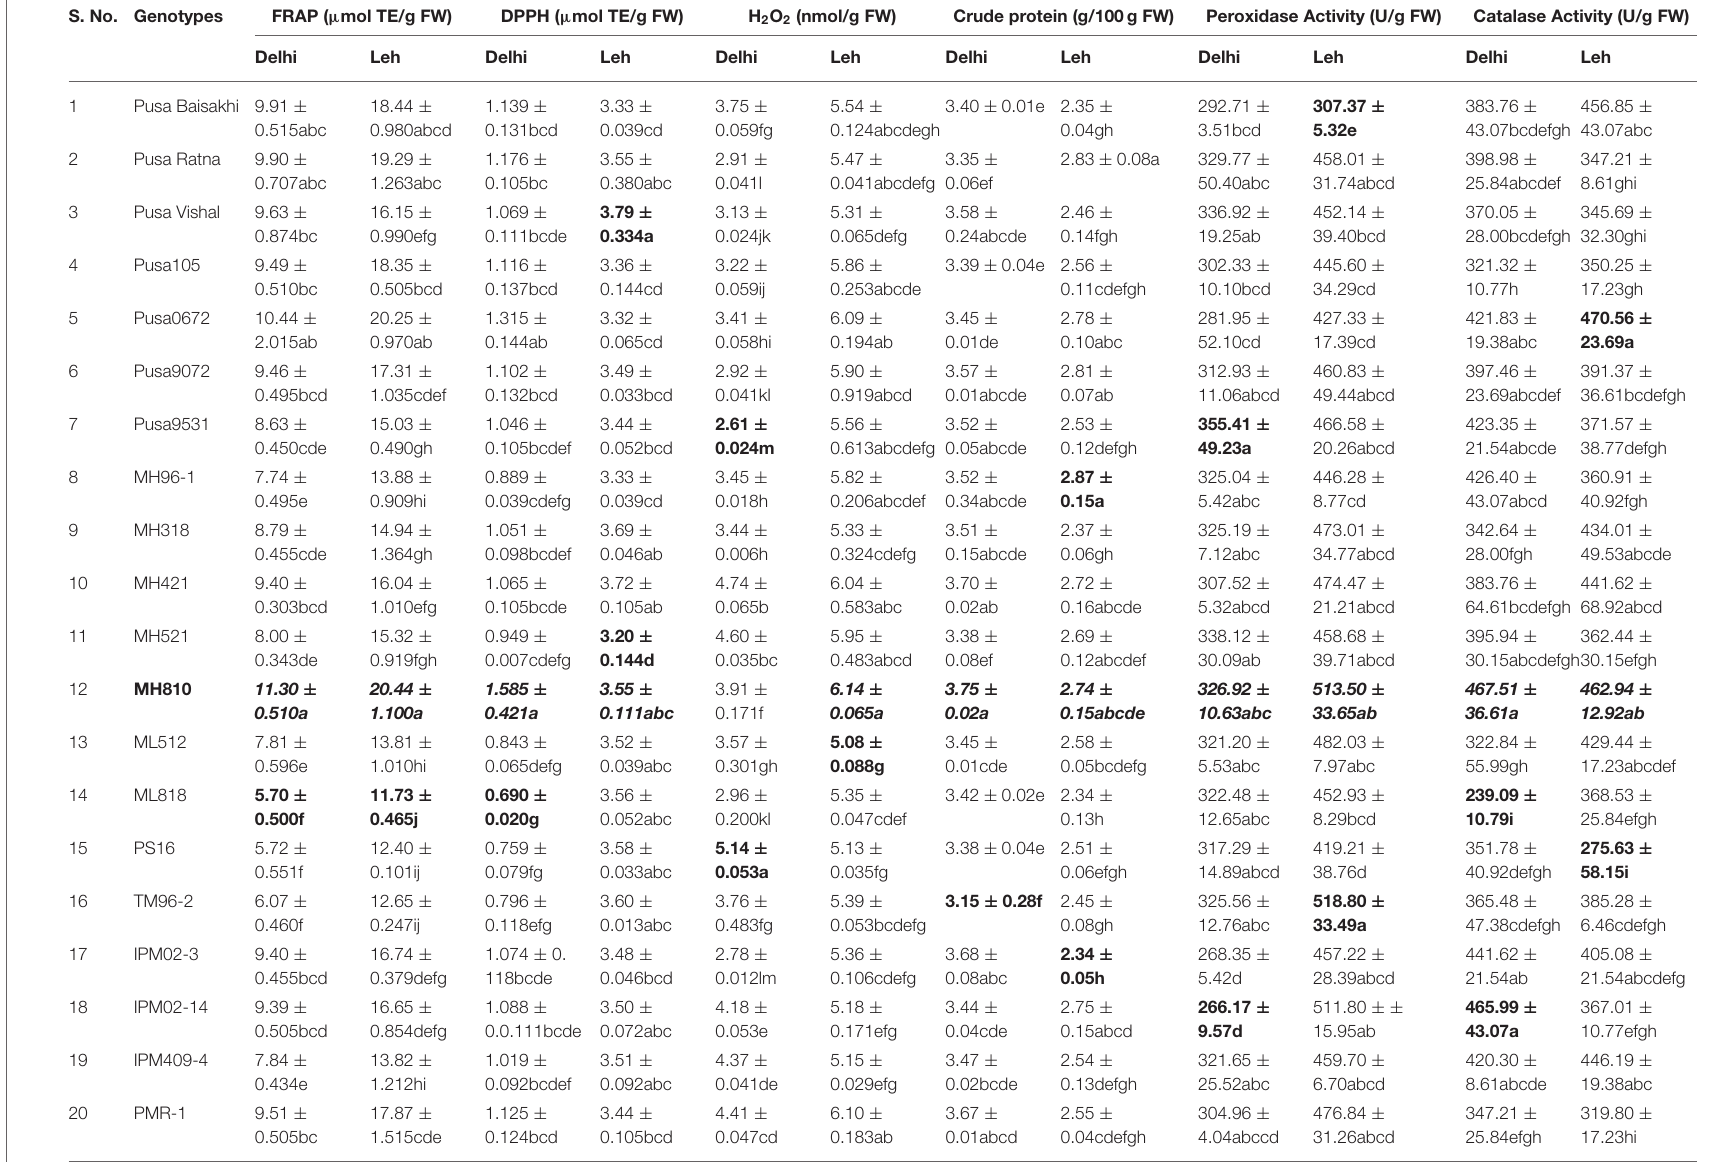
TABLE 3 | Total antioxidant activity, crude protein, and antioxidant enzymatic activities in the mungbean microgreens grown under Delhi and Leh conditions. S. No.